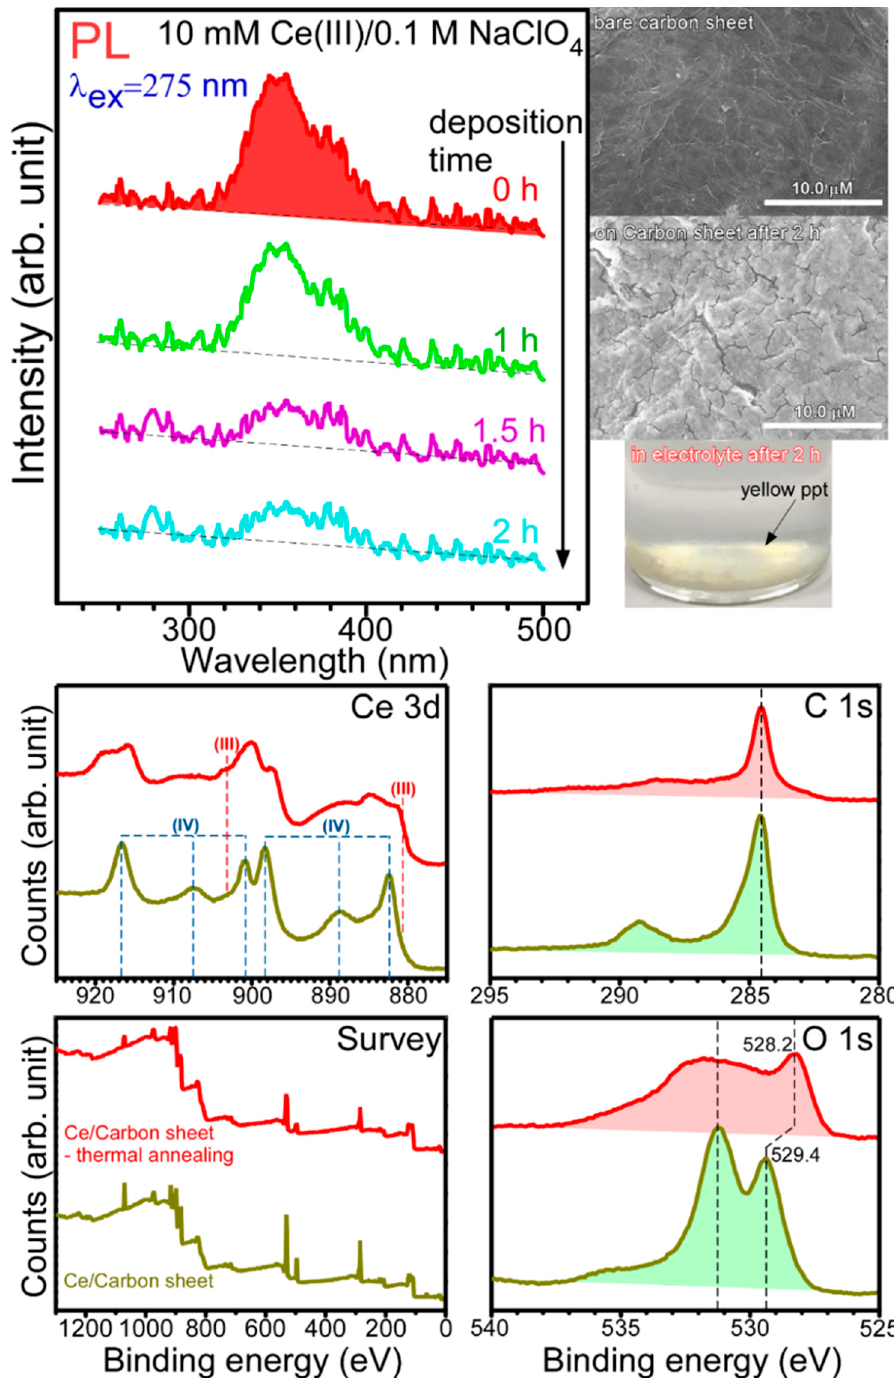
Figure 7. Photoluminescence spectra (top left) of 10 mM Ce(III)/0.1 M NaClO 4 electrolyte with electrodeposition time; SEM images (top right) of the carbon sheet before and after electrodeposition, and a photo of the electrolyte after electrodeposition; and Ce 3d, C 1s, survey, and O 1s XPS profiles before and after thermal annealing at 550 °C.